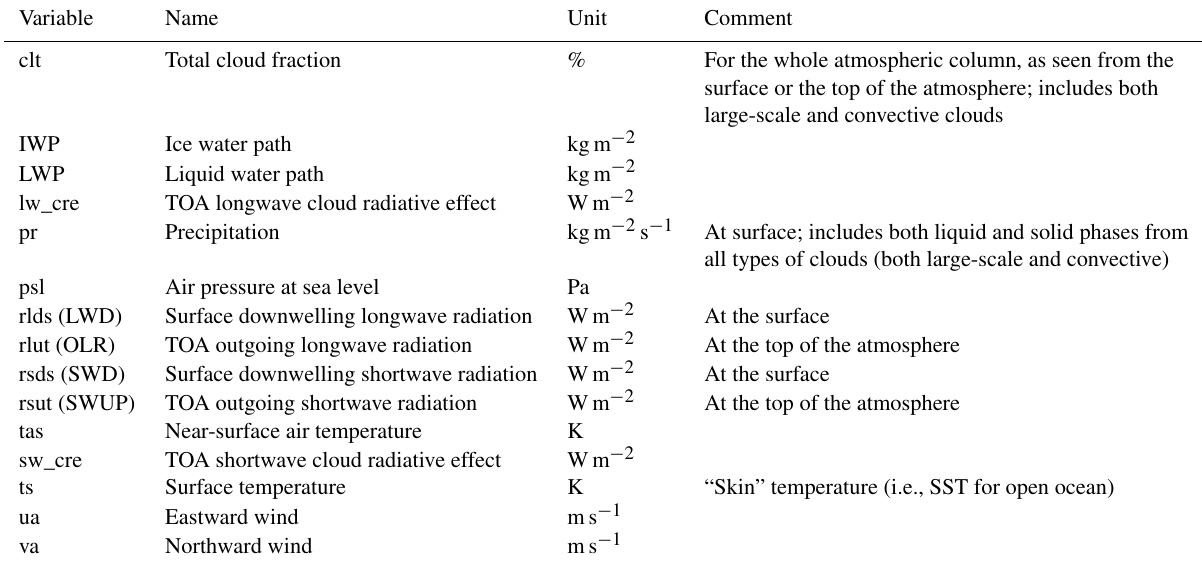
Table 4. Variables